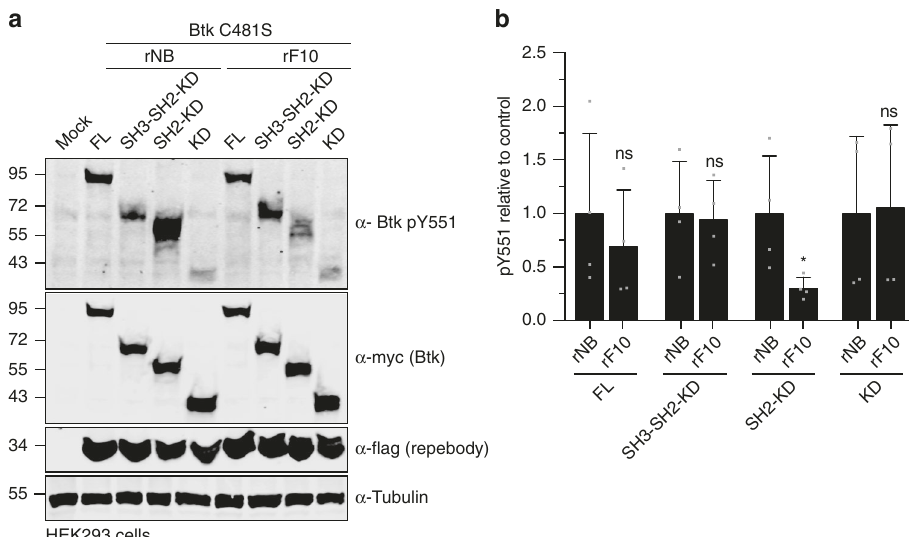
Fig. 8 Targeting the Btk SH2-KD interface decreases activation of therapy-resistant Btk with mutation on C481. a Immunoblot analysis of cell lysates from HEK293 cells transiently co-transfected with indicated Btk C481S constructs and repebodies used to assess Btk pY551 phosphorylation. b Quanti fi cation of pY551 shown in a normalized to total Btk (Myc) expression and relative to rNB control. Data are mean ± SD of two biological replicates ( n = 3) and P -values were calculated using an unpaired t -test. * P ≤ 0.05. Source data are provided as a Source Data fi (Supplementary Fig. 7a, b) of Btk C481S SH2-KD expressed in HEK293 cells and to a similar extent than of wild-type SH2-KD.